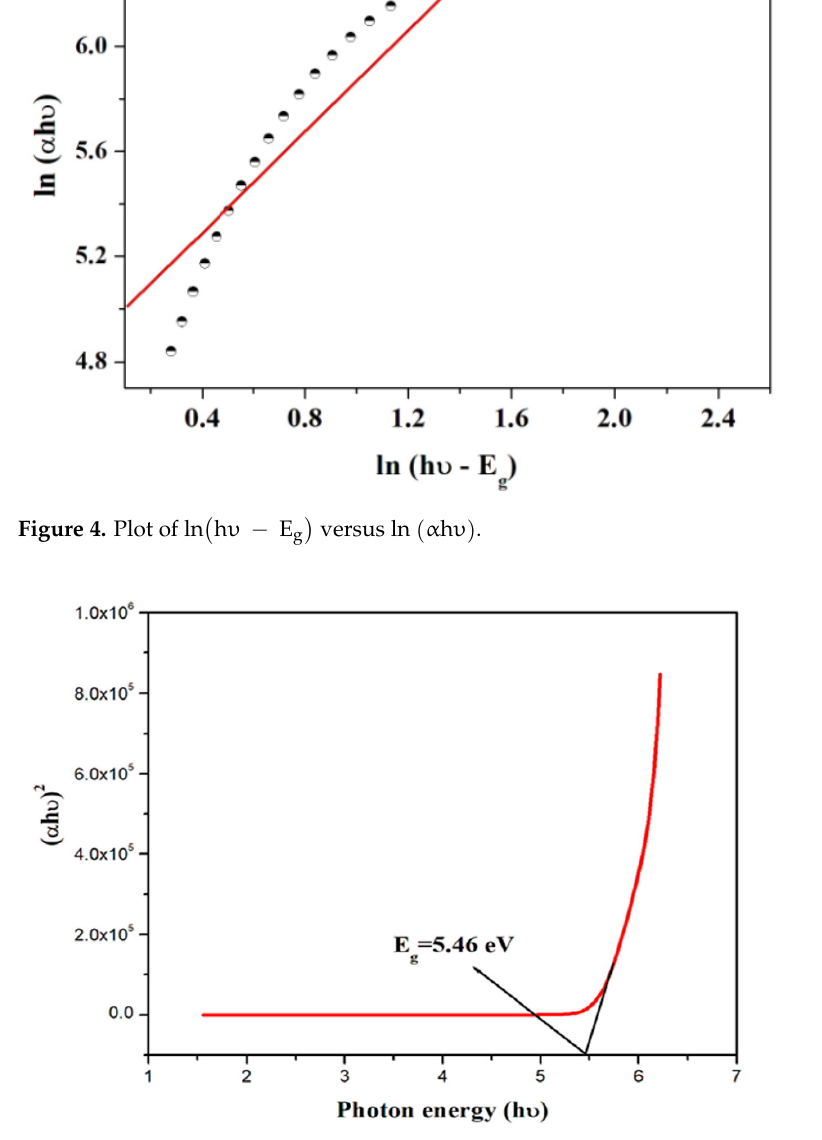
Figure 5. Band gap Spectra —Tauc’s Plot .